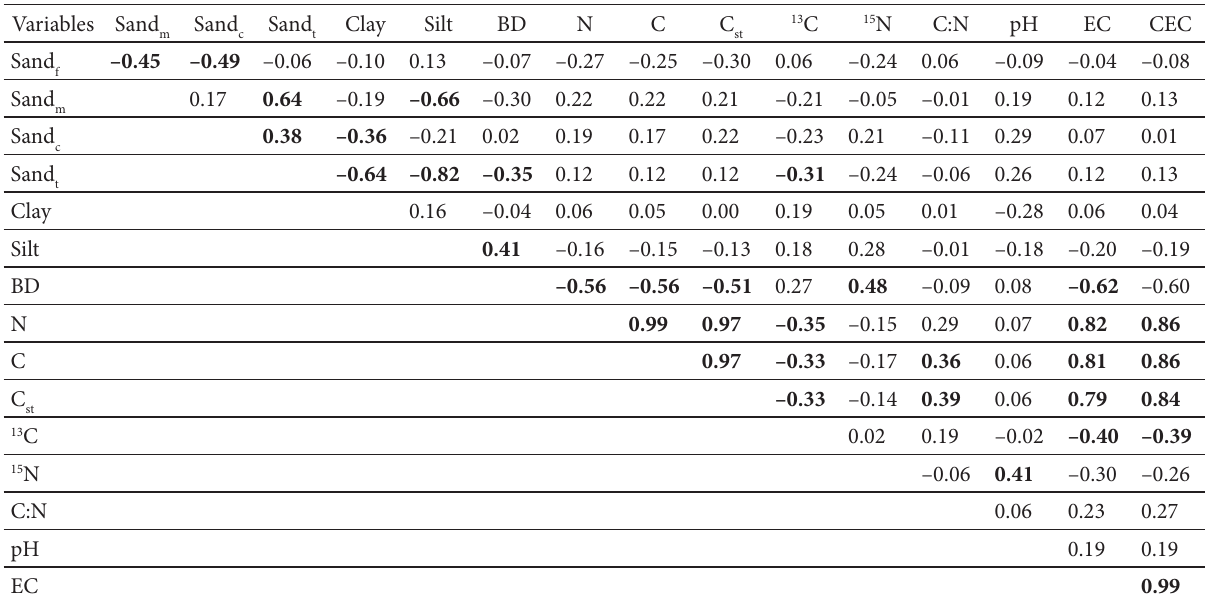
Table 3. Spearman correlation matrix for soil attributes. Values in bold mean statistically significance at P = 5% Variables Sand Sand Sand m c